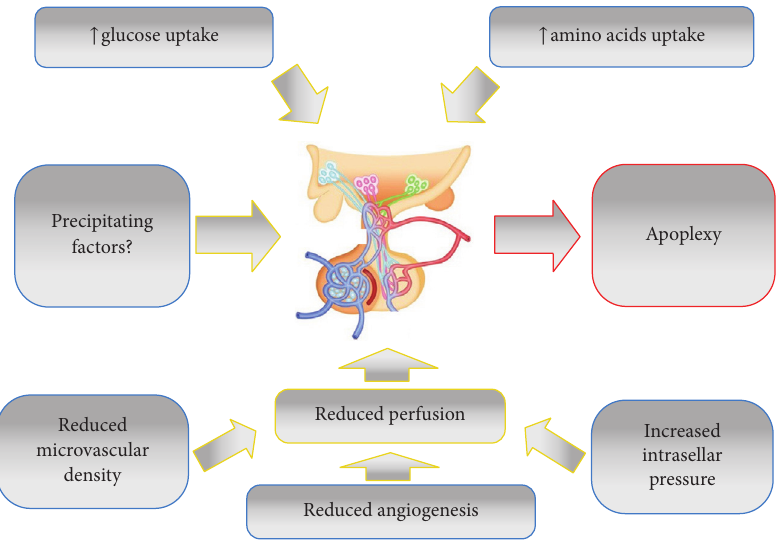
Figure 1: Pathophysiology of pituitary